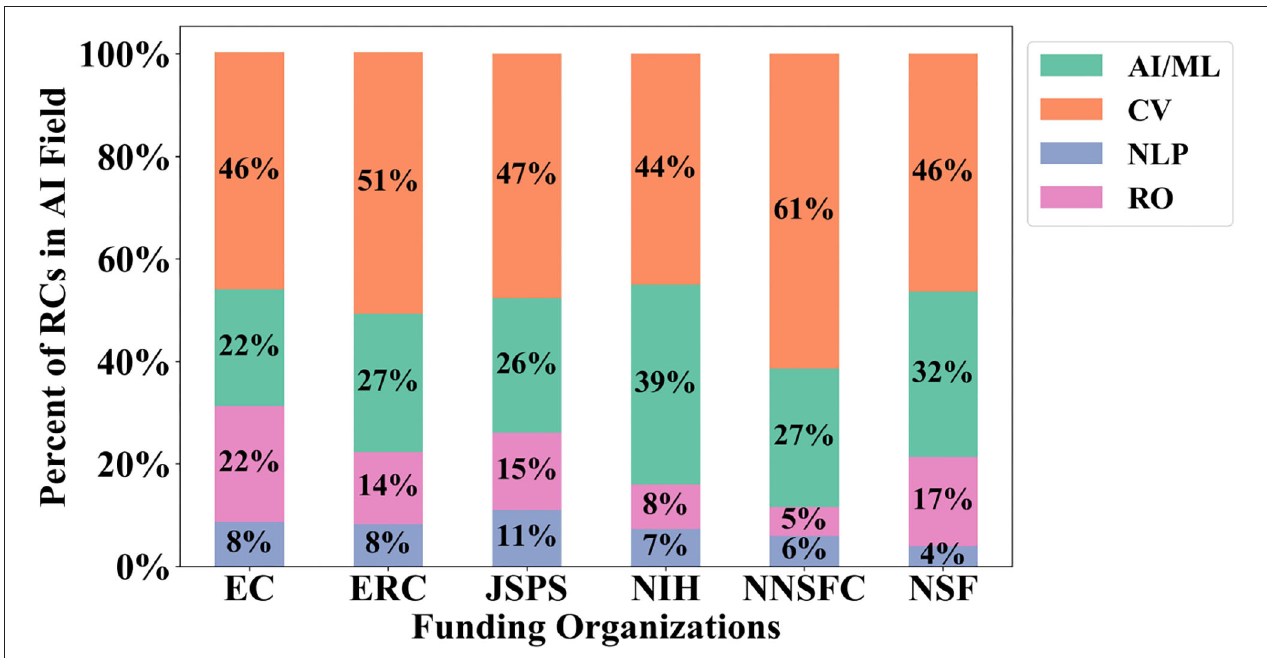
FIGURE 6 | Research cluster (RC) funding portfolio breakdown by funder and AI field.